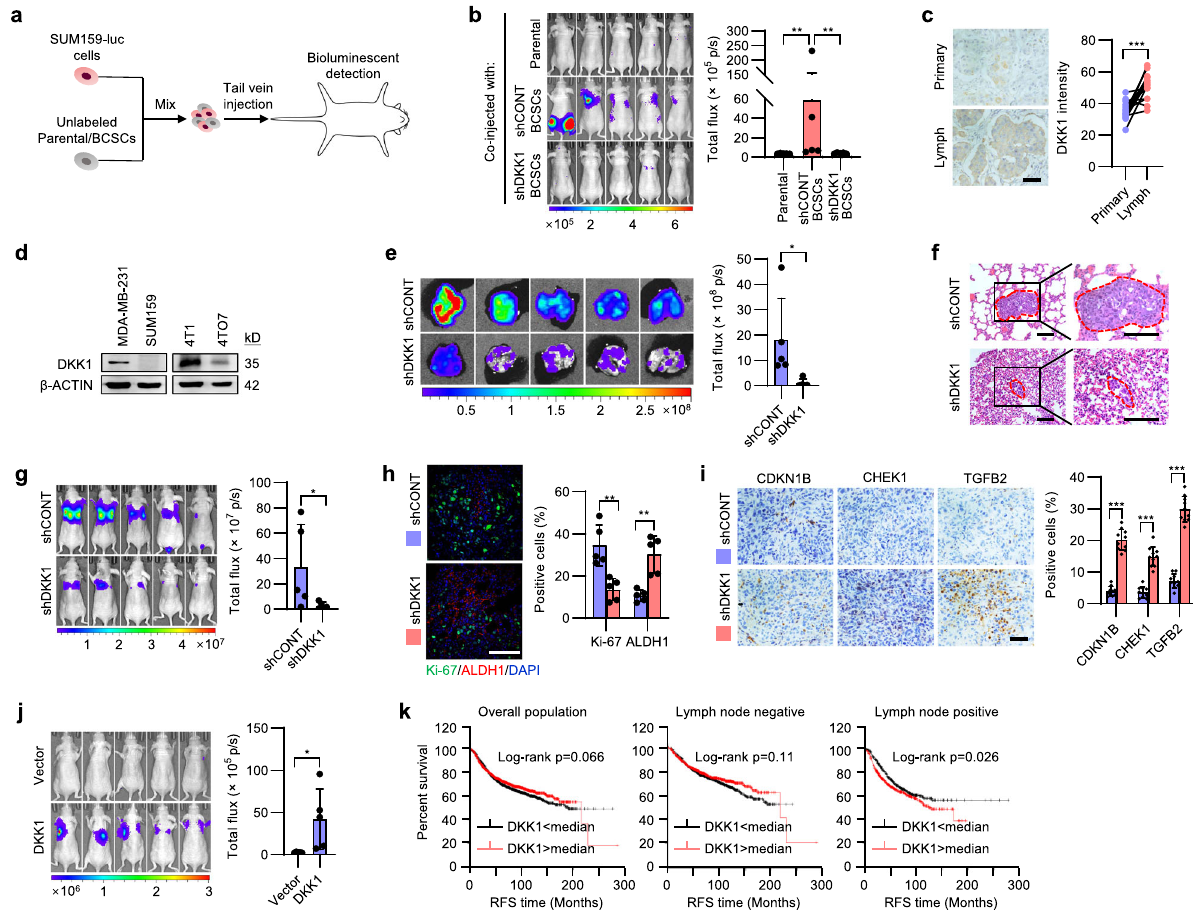
Fig. 3 BCSC-secreted DKK1 enhances metastatic colonization. a The schematic of co-implantation model. The 1 × 10 6 luciferase-labeled SUM159-luc cells were intravenously co-injected with 4 × 10 5 unlabeled mammosphere-enriched shCONT BCSCs, shDKK1 BCSCs or parental cells into the host mice. BLI was performed on the metastatic burden of SUM159-luc cells. b BLI was performed on the metastatic burden of SUM159-luc cells. c Immunohistochemical (IHC) staining of DKK1 in 15 pairs of human primary breast cancer and lymph node metastases. Scale bar: 50 μ m. d Immunoblot assessment of DKK1 protein levels. e , f BLI ( e ) or H&E staining ( f ) of the lungs from mice orthotopically implanted with 2 × 10 6 MDA-MB-231-shCONT or -shDKK1 cells 4 weeks later. Scale bar: 100 μ m. g BLI of the metastatic burden of mice intravenously injected with 1 × 10 6 MDA-MB-231-shCONT or -shDKK1 cells. h , i Immuno fl uorescent (IF) staining of Ki-67 and ALDH1 ( h ) or IHC staining of CDKN1B, CHEK1 and TGFB2 ( i ) in lung sections from mice intravenously injected with MDA-MB-231-shCONT or -shDKK1 cells. Scale bar in ( h ): 100 μ m. Scale bar in ( i ): 50 μ m. j BLI of the metastatic burden of mice intravenously injected with 1 × 10 6 SUM159-Vector or SUM159-DKK1 cells. k Kaplan – Meier plots of relapse-free survival (RFS) in the indicated population of breast cancer patients strati fi ed according to tumor DKK1 expression. The data was analyzed in all molecular subtypes of breast cancer. Results are shown as mean ± S.D. * P < 0.05; ** P < 0.01; *** P < 0.001; ns not signi fi cant (Paired two-tailed Student ’ s t test in ( c ) others unpaired two-tailed Student ’ s t test). Source data are provided as a Source Data fi